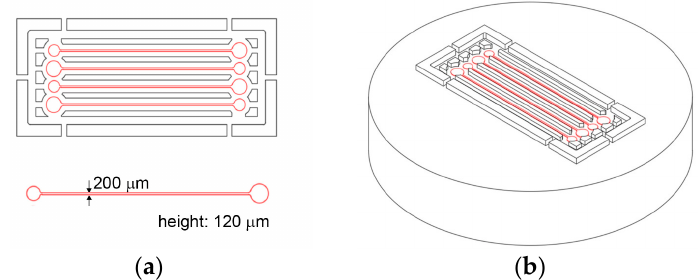
Figure 1. ( a ) Design of microfluidic channels. Channel width and height are 200 µm and 120 µm, respectively. ( b ) 3D illustration of the master mold design containing four microfluidic channels.